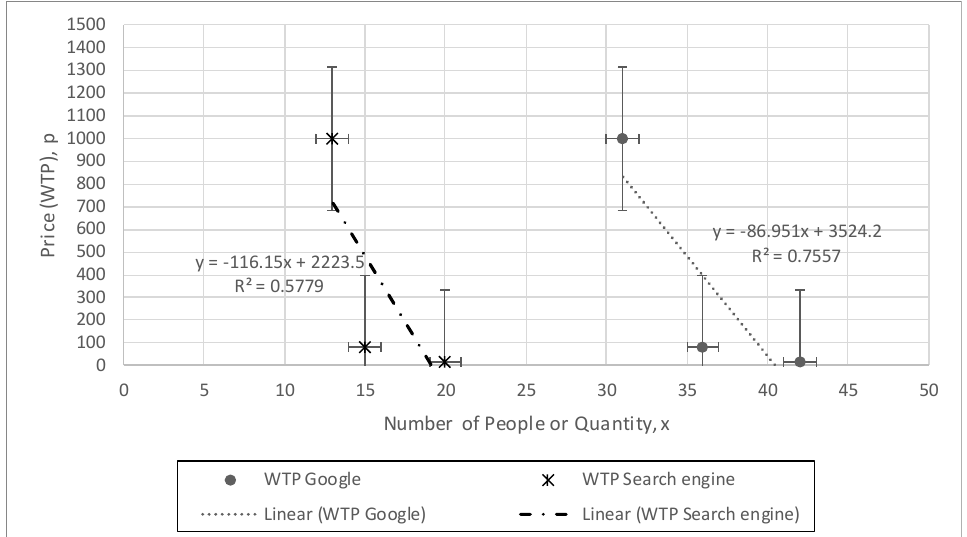
Figure A2. WTP of Google and search engines over different times (one week, one month, and one